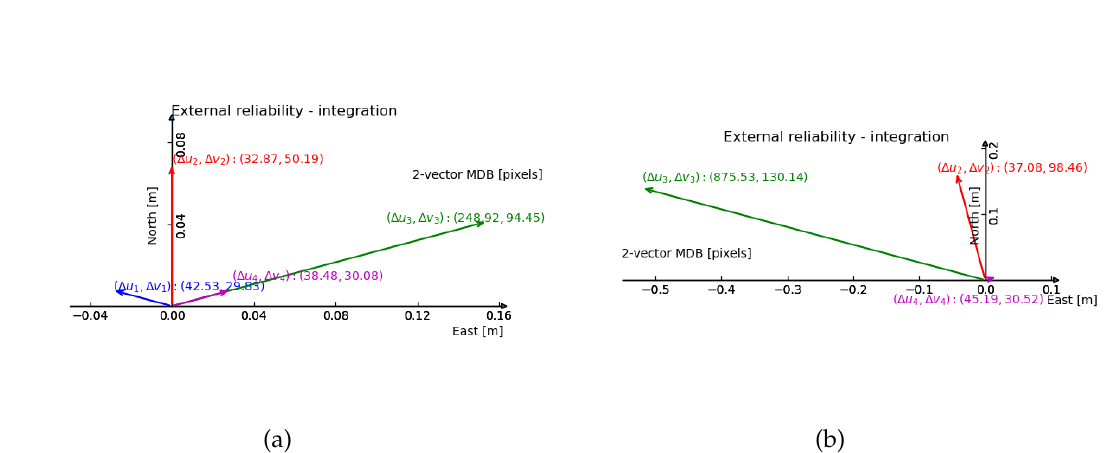
Figure 14. 2-vector external reliability of vision measurements in the integration model with 8 satellites and 4 features ( a ), and with 3 satellites and 3 features ( b ). The bias vector with largest magnitude is shown (in terms of horizontal position) and the corresponding internal reliability values are given between